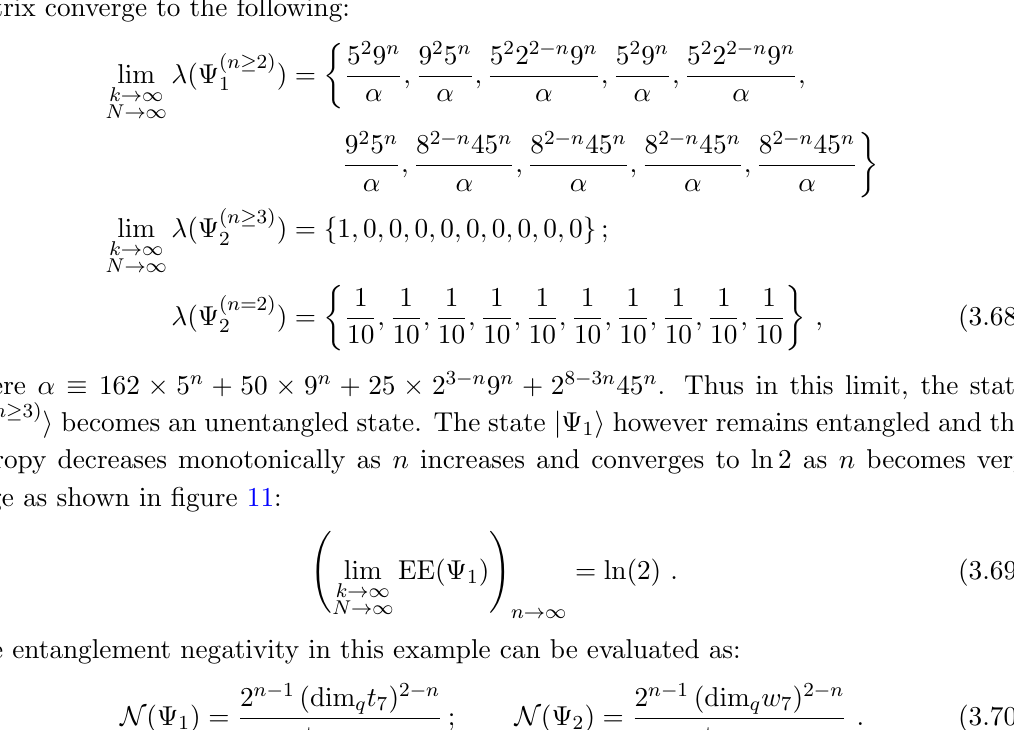
Figure 11 . The plot showing the variation of lim( k !1 is maximum (ln 10) at n = 2 and converges to ln 2 as n ! 1